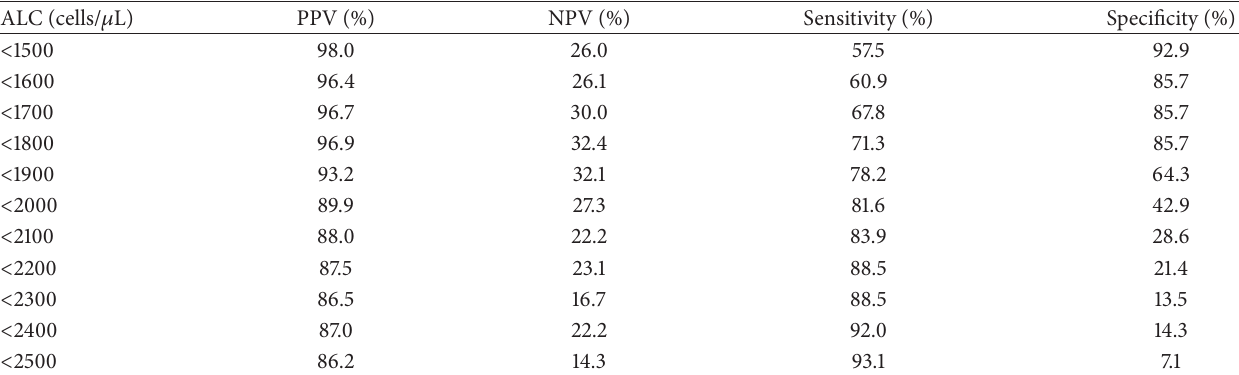
Table 2: Calculated positive predictive values (PPV), negative predictive values (NPV), and sensitivities and specificities of absolute lymphocyte counts (ALC) for CD4 count ≤ 350 in all the paired counts ( 𝑛 = 101 ). ALC (cells/ 𝜇